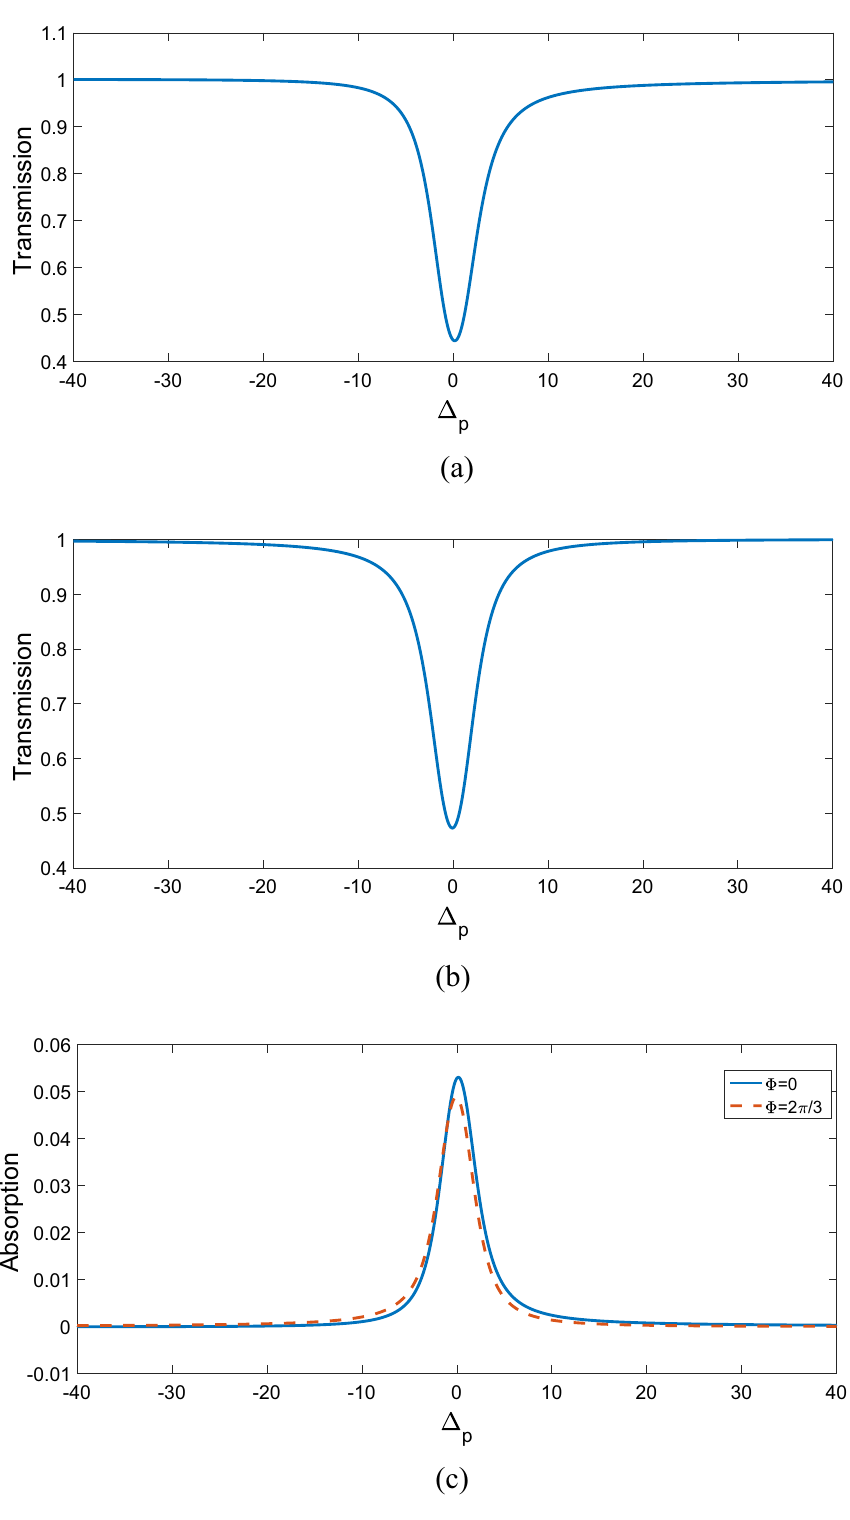
Figure 8. Transmission coefficient of probe field versus normalized probe filed detuning for (cid:31) = 0 ( a ), � = 2 π 3 ( b ). Absorption coefficient of probe field versus normalized probe filed detuning for (cid:31) = 0 and � = 2 π 3 ( c ). Other parameters are same as in Fig.